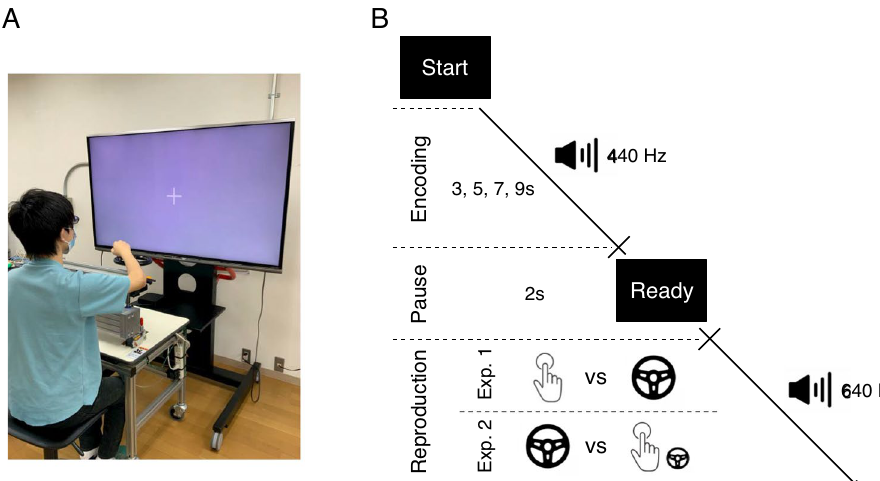
Figure 1. Apparatus and the temporal reproduction task. Participants were seated in front of a table with a keypad and a steering wheel which were placed in front of a monitor ( A ). In the temporal reproduction task ( B ), participants reproduced the duration of previously presented tones by pressing the key twice (the single action condition) or turning the steering wheel (the continuous action condition) or pressing the key twice while turning the steering wheel (the extra continuous action